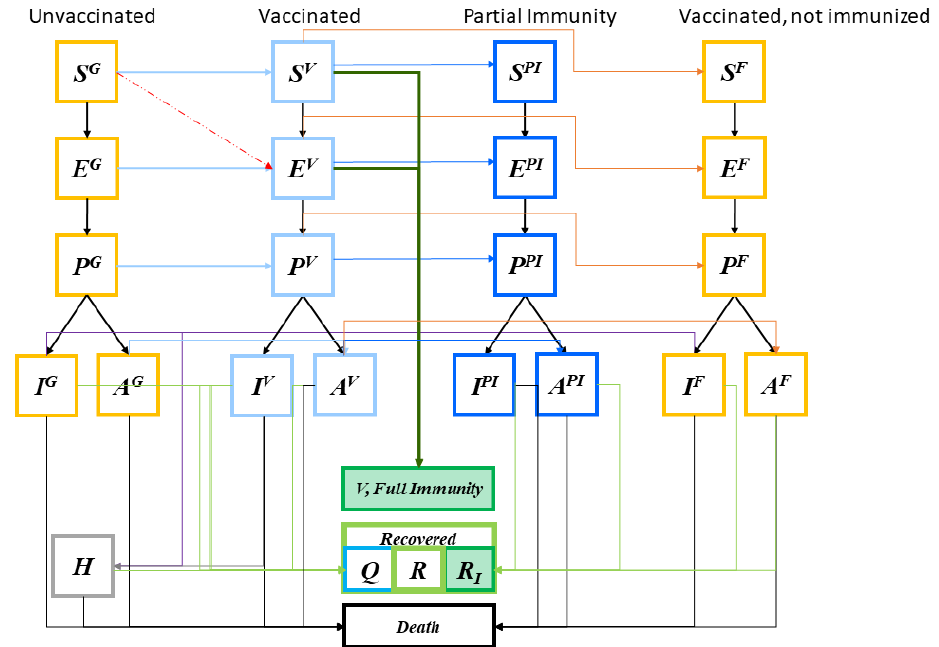
Figure 3. Immunity and disease stages of individuals upon vaccination. Individuals may become exposed to the disease during the vaccination process (red arrow). Once vaccinated, it typically takes a few weeks for the body to establish immunity against the virus. A person could still get COVID-19 just after vaccination (the light-blue disease progression). Some vaccinated people may develop only partial immunity and may contract disease still, although mostly with only mild or no symptoms at all (dark blue disease progression). A small percentage may fail to develop immunity.